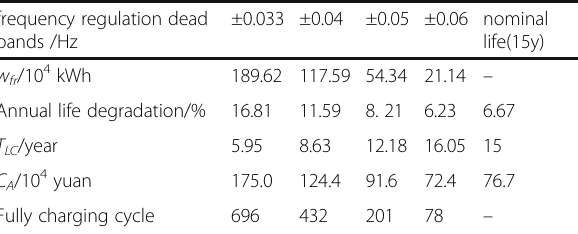
Table 2 Estimated operating life and annual average cost of the Li-ion ESS under different frequency regulation dead bands frequency regulation dead bands /Hz